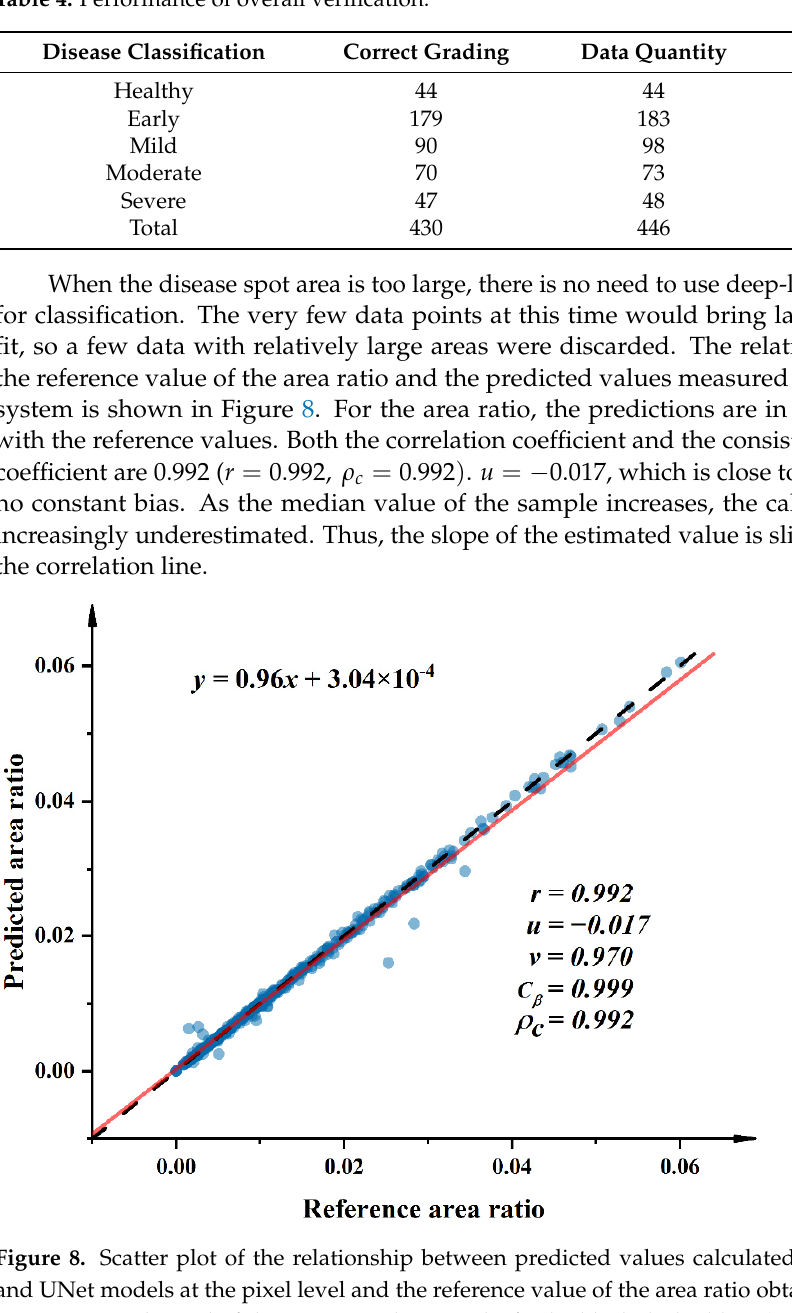
Table 4. Performance of overall verification.